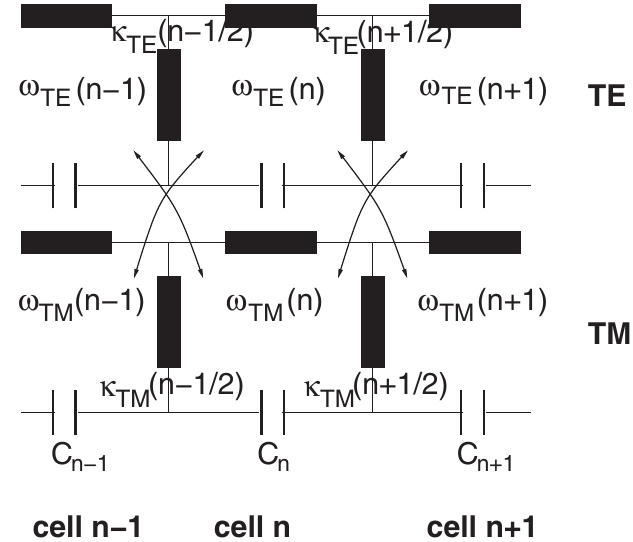
FIG. 14. Double resonator chain used to model the collective wake in the lowest two dipole bands. It is fully characterized by the resonant frequencies and cell-to-cell couplings ! and (cid:3) for the TE and TM parts as well as the TM capacitor giving the coupling to the